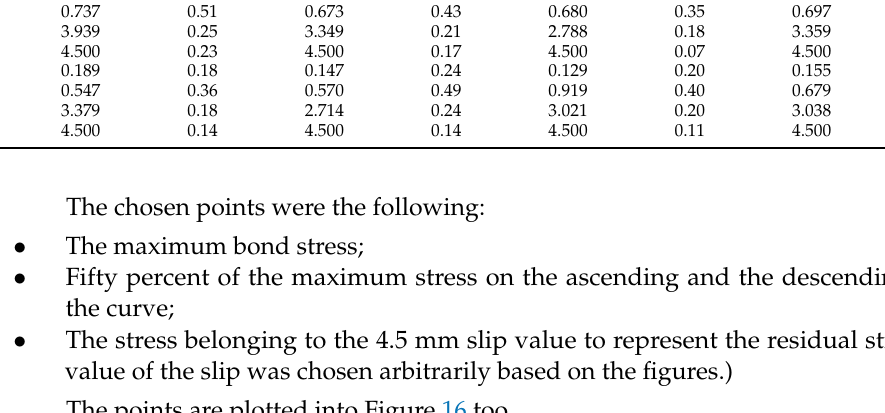
Table 8. Bond strength and slip of NWAC and LWAC.